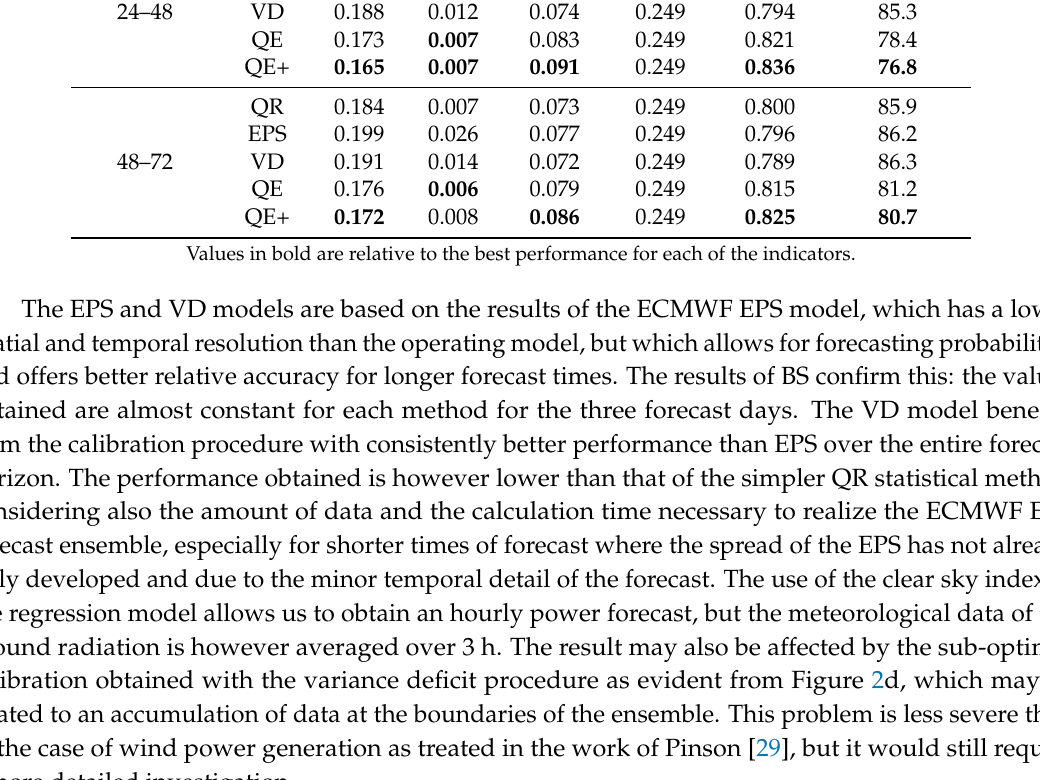
Table 5. Probabilistic error measures with different forecast lead times. The Brier Score (BS), its components reliability (REL), Resolution (RES) and Uncertainty (UNC) and the Area Under the ROC Curve (AUC) are calculated for a threshold of 0.5 · p cs . The cumulative ranked probability score is the mean value for the test set in the daylight hours only.